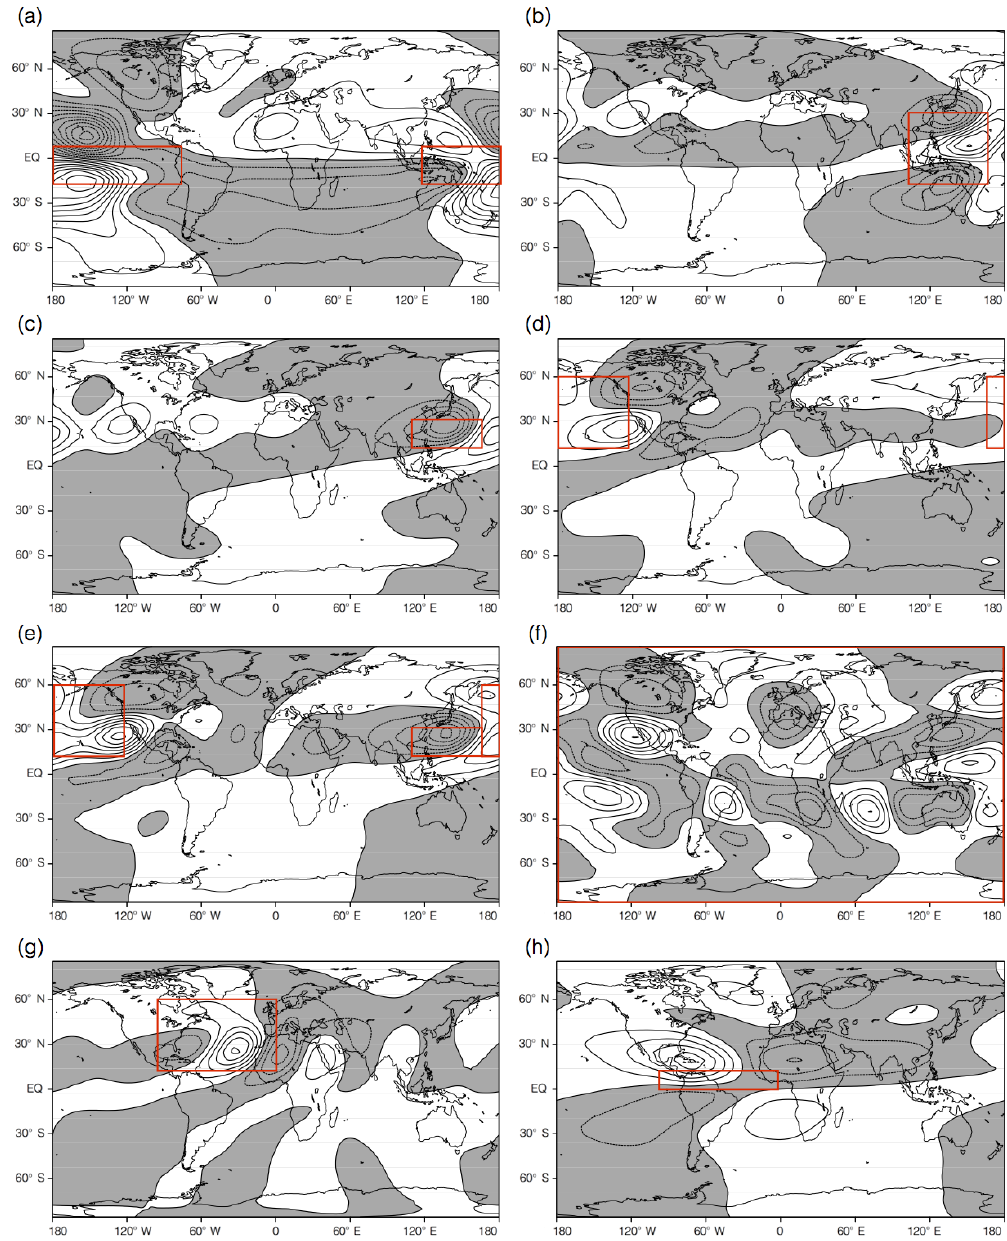
Figure 9. The 250hPa stationary wave anomaly from LUMA when forced with the HadGEM3-GC2, (1998–2012) vs. (1979–1993), precip- itation anomaly (a) from the equatorial Pacific (15 ◦ S to 10 ◦ N, 120 ◦ E to 75 ◦ W); (b) downstream of China and Indonesia (15 ◦ S to 30 ◦ N, 100 to 160 ◦ E); (c) downstream of China (15 ◦ S to 30 ◦ N, 110 to 160 ◦ E); (d) the northern North Pacific (15 to 60 ◦ N, 160 to 240 ◦ E); (e) the sum of regions (c) and (d) ; (f) the whole globe; (g) the North Atlantic (15 to 60 ◦ N, 0 to 90 ◦ W), and (h) the tropical North Atlantic (0 to 15 ◦ N, 0 to 90 ◦ W). Grey shading and dashed contours indicate negative anomalies, white shading and solid contours indicate positive anomalies. Red boxes indicate the location of the precipitation